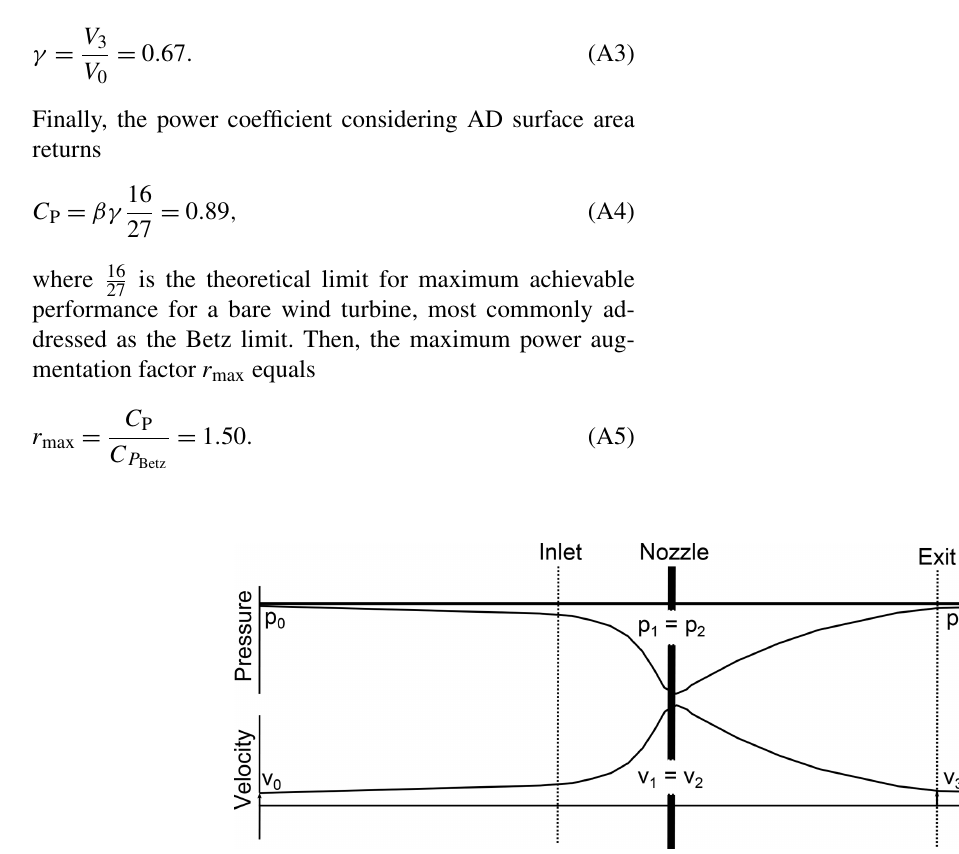
Figure A1. Pressure and velocity relations in a DWT using